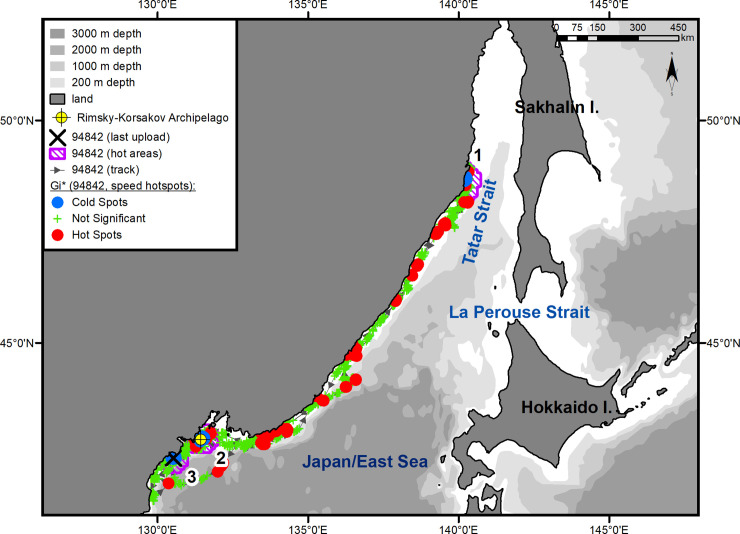
Summer–autumn migrations of underyearling female #94842.